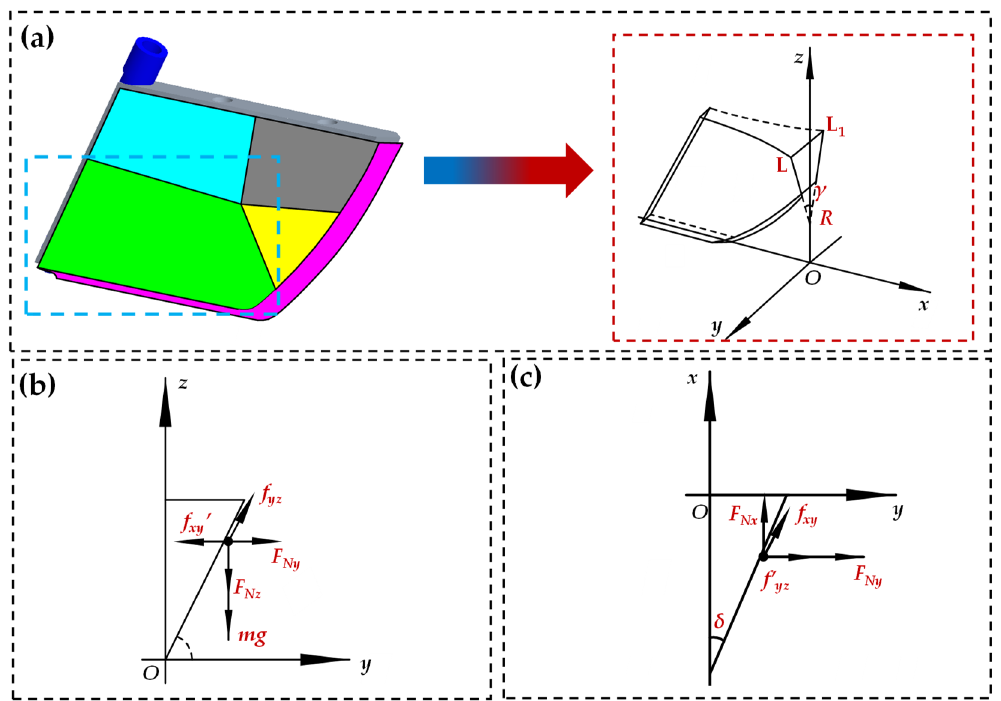
Figure 14. Schematic diagram of the guide inclined surface structure. Schematic diagram of the shaping surface structure and soil particle kinematics analyses. ( a ) Schematic diagram of the disturbed soil surface structure. ( b ) Force analysis on the yOz plane. ( c ) Force analysis on the xOy plane. Sort Equation